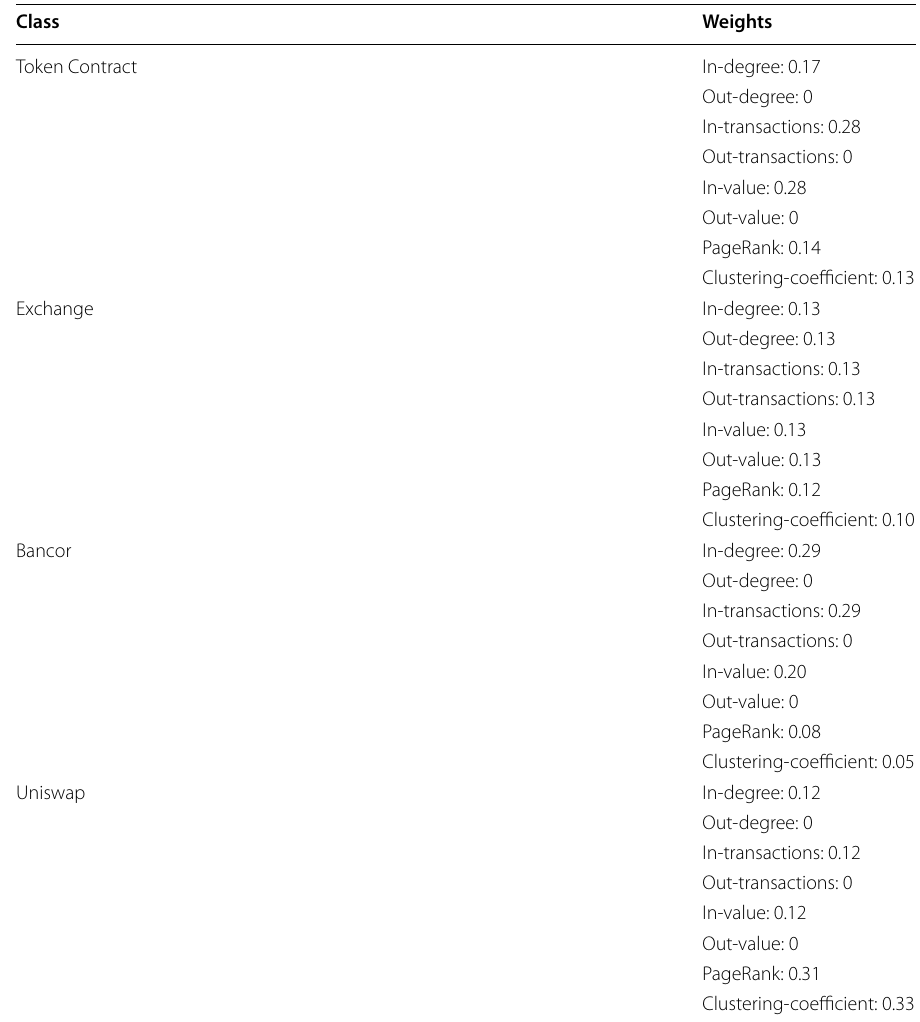
Table 15 The best weight combination for the Eros distance obtained by applying our heuristics on testing data Class